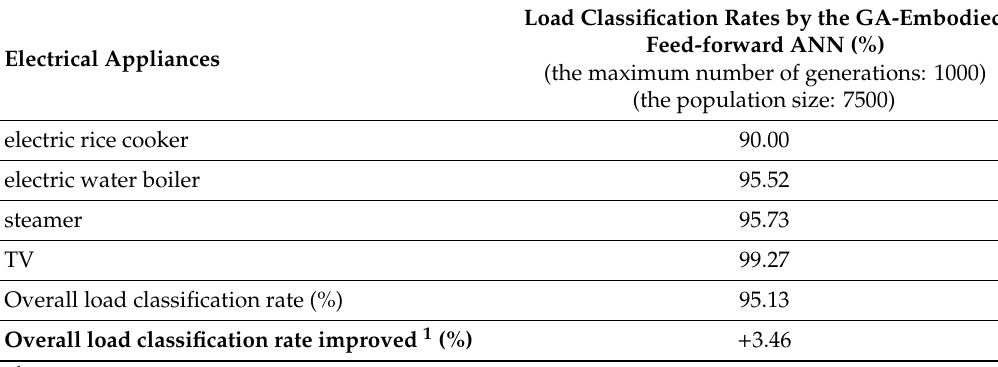
Figure 14. Trajectory of the parallel GA used to meta-heuristically train the feed-forward ANN. In total, 7,507,500 feed-forward ANNs differing in their trainable weight coefficients are considered and they are examined through parallel computing, and the algorithm takes 85.21 mins for the evolution. Table 3. Load classification rates obtained by the parallel GA embodied and used to meta-heuristically train the feed-forward ANN in this experiment.